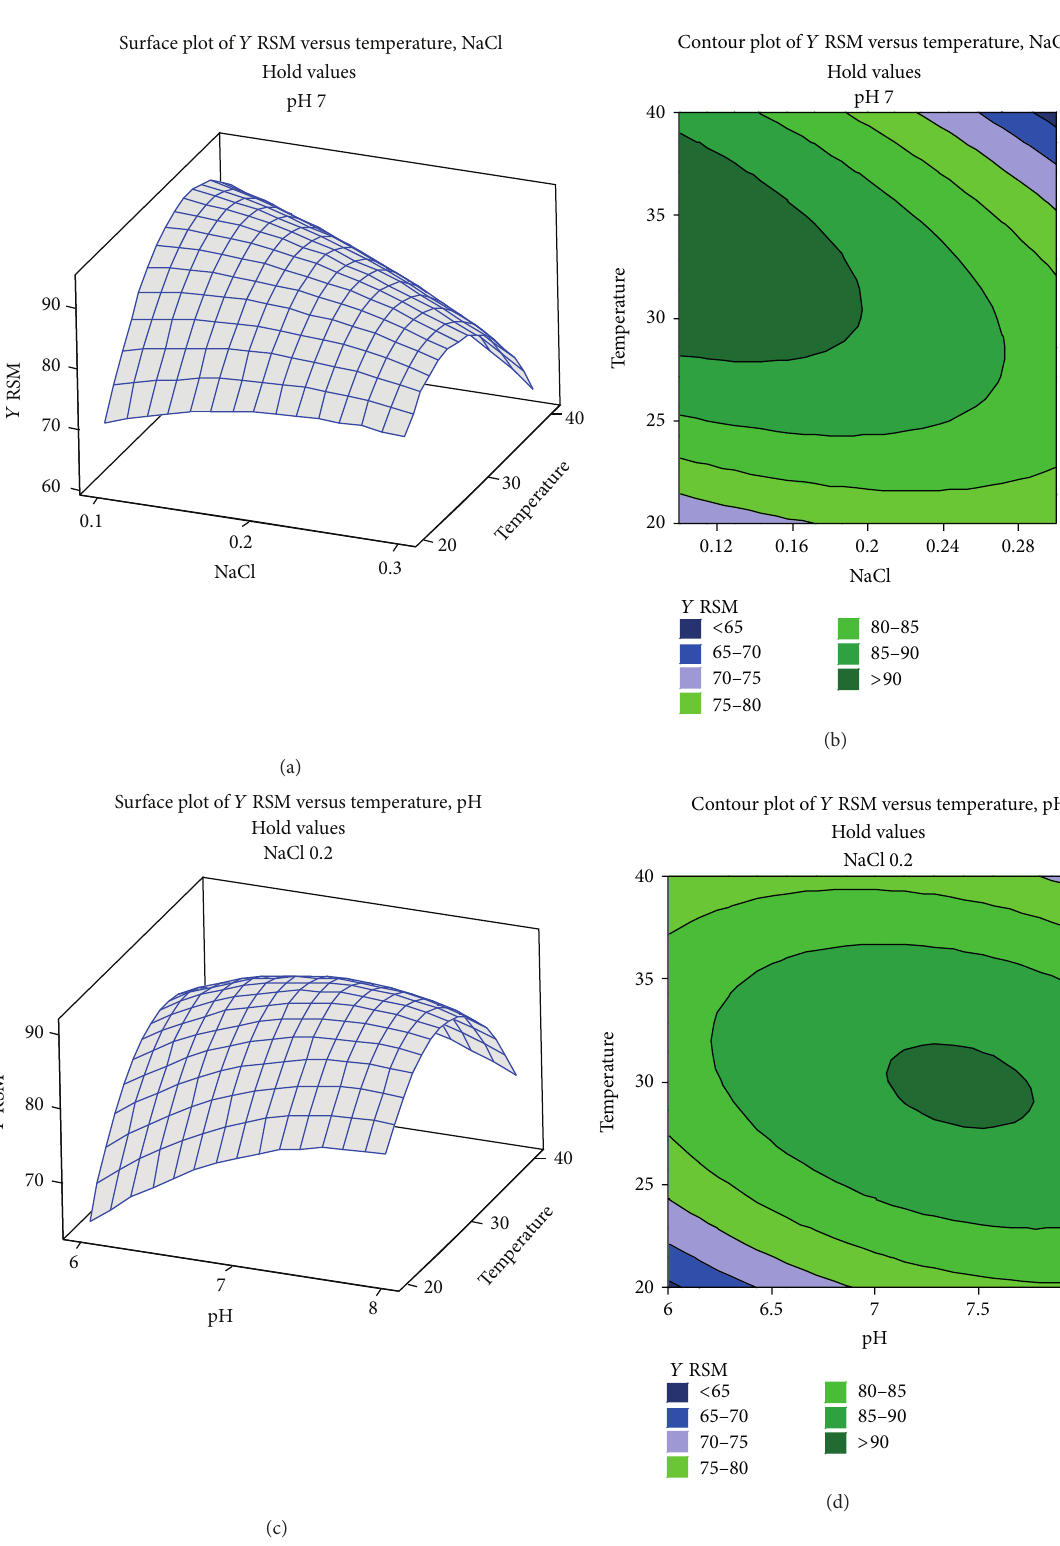
Figure 5: Response surface and contour plots showing the effect of process variables in uncoded values on % recovery. ((a) and (b)) NaCl and temperature; ((c) and (d)) pH and